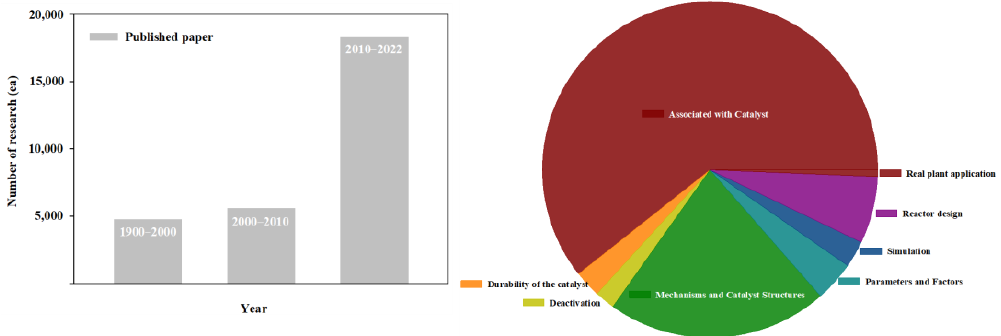
Figure 2. Trend of CO 2 methanation research according to Year ( left ) and The fields of CO 2 methana- tion studied over the last 10 years (2012–2022) ( right ).